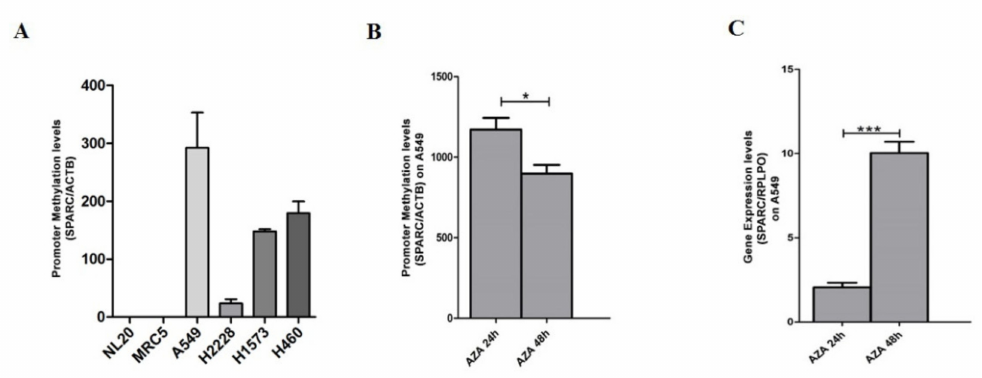
Figure4. ( A )RepresentativeQMSP analysisshowing thecomparisonbetween thepromotermethylation levels of SPARC in NSCLC cell lines (A549, H2228, H1573, H460). Two normal lung cell lines NL20 and MRC-5 were used as negative controls. Changes in ( B ) SPARC promoter methylation levels detected by QMSP and ( C ) SPARC mRNA transcript levels by quantitative real-time (RT-qPCR) in the A549 cell line before and after treatment with 5 µ m of 5-azacytidine (5-aza-Dc, AZA) at 24 (AZA 24 h) and 48 h (AZA 48 h). Error bars indicate the standard deviation of three di ff erent experiments. * p < 0.05, *** p < 0.001 ( t